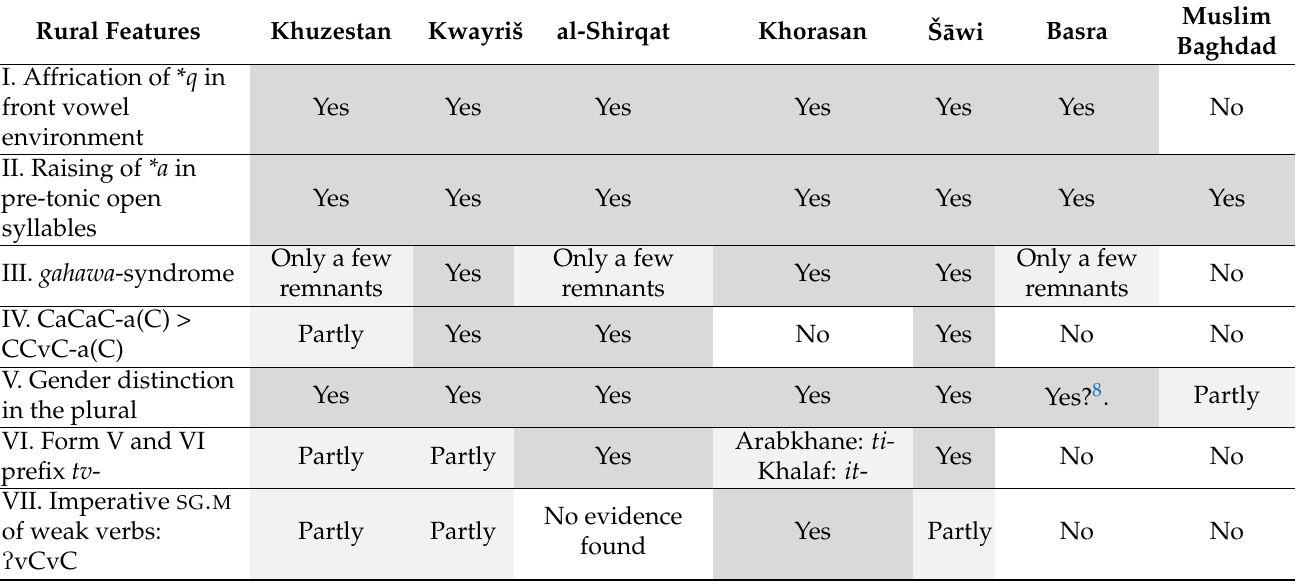
Table 1. Distribution of (possible) rural g @ l @ t features 7